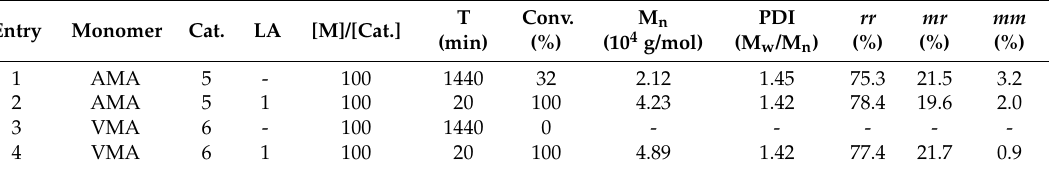
Table 2. Chemoselective polymerization of AMA and VMA with complexes 5 and 6 . a